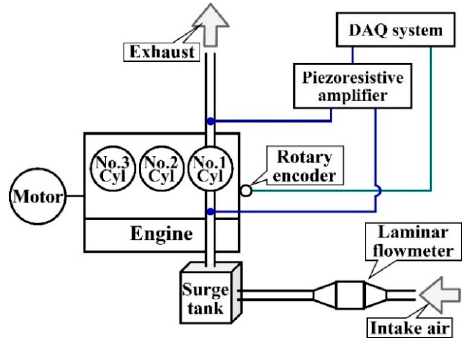
Figure 2. Block diagram of the experimental system. DAQ: data acquisition.